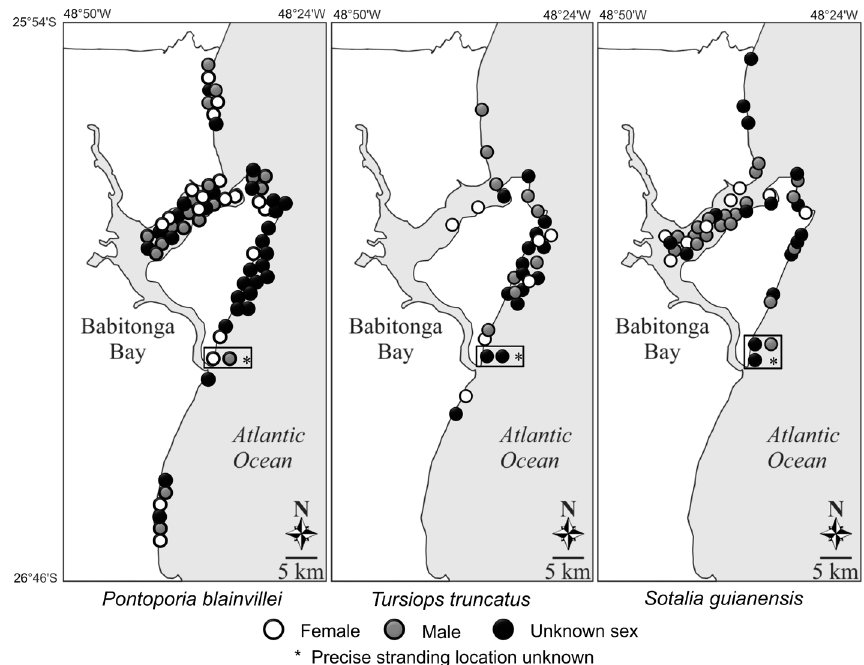
Figure 6. Spatial distribution of strandings of Pontoporia blainvillei , Tursiops truncatus , and Sotalia guianensis in the north region from 1983 to